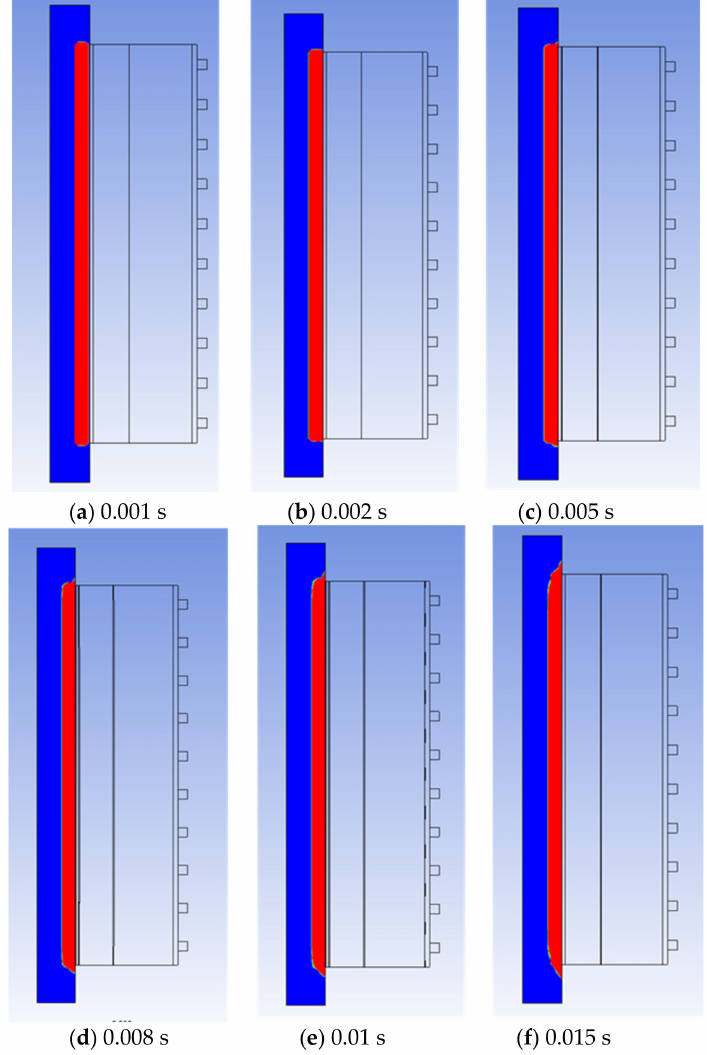
Figure 15. Local FSI model using a fluid column: ( a ) at 0.001 s; ( b ) at 0.002 s; ( c ) at 0.005 s; ( d ) at